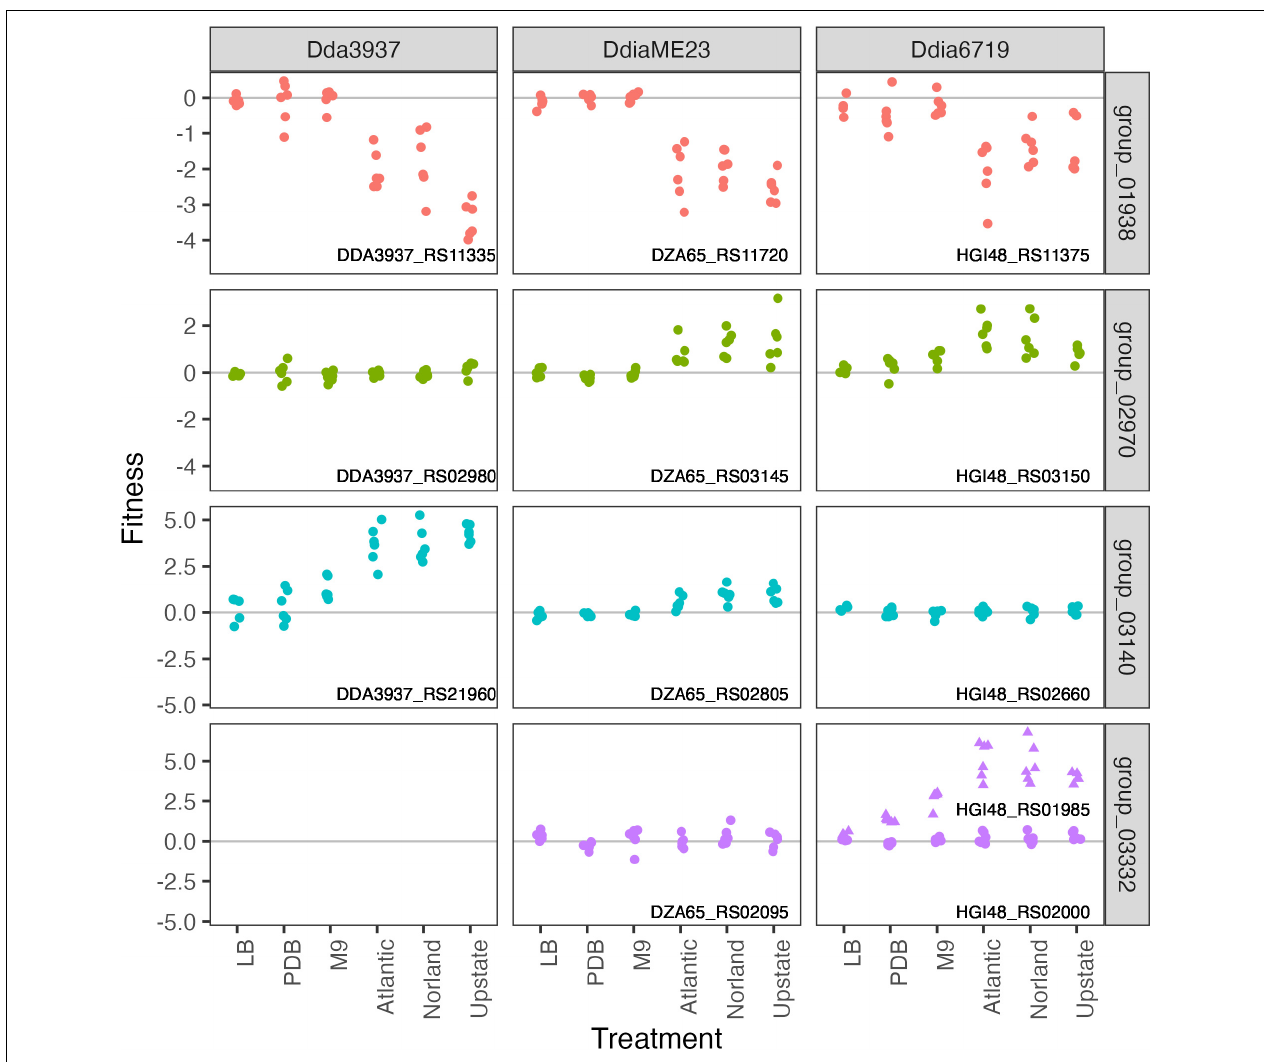
FIGURE 7 | In tubers, pectin degradation contributes to growth, while the role of putative DNA-binding proteins varies among strains. Pectin degradation by 2-dehydro-3-deoxy-D-gluconate 5-dehydrogenase KduD (group 01938) is specifically important for growth in tubers. Gene fitness values shown for three putative DNA binding proteins: ortholog groups 02970, 03140, and 03332. No ortholog was detected in D. dadantii 3937 for group 03332 (helix-turn-helix transcriptional regulators). In D. dianthicola 67-19, there are two genes in group 03332 (HGI48_RS01985, triangles; HGI48_RS02000, circles). All other orthogroup members are single-copy in each